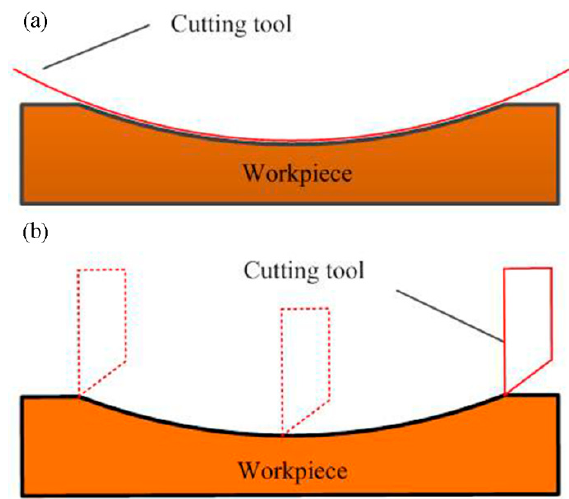
Figure 1. Schematic of the trajectory method. ( a ) The axial direction; ( b ) the circumferential direction.